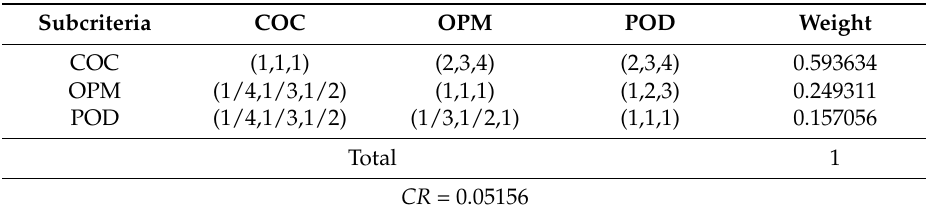
Table A5. Comparison matrix for EFC based on subcriteria.